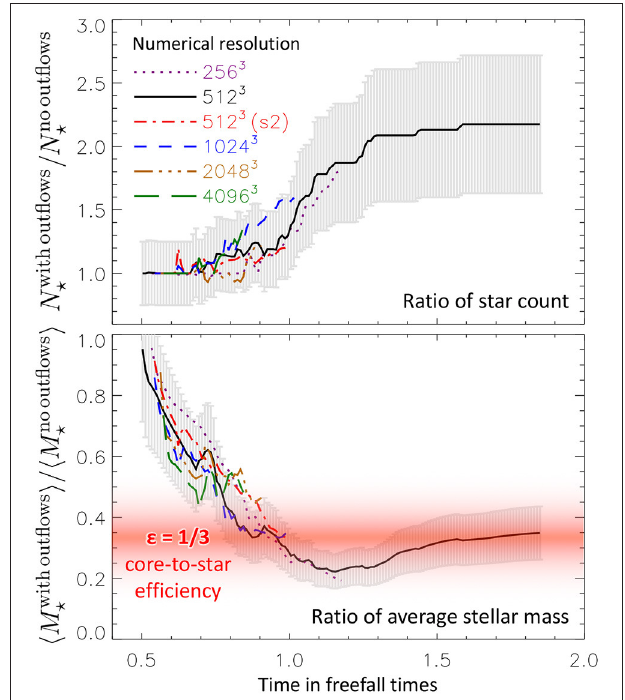
FIGURE 7 | Time evolution of the ratio of the number of sink particles formed in simulations with and without magneto-centrifugal outflows, N withoutflows ⋆ / N nooutflows ⋆ (top) , and ratio of the average sink particle mass M withoutflows ⋆ M nooutflows ⋆ / (bottom) . Different lines show different h i h i numerical resolutions, demonstrating convergence. After a freefall time, outflow feedback has increased the number of sink particles formed by a factor of 1.5. The average sink particle mass is reduced by a factor of ∼ with outflow feedback. Figure adopted from Federrath et al.